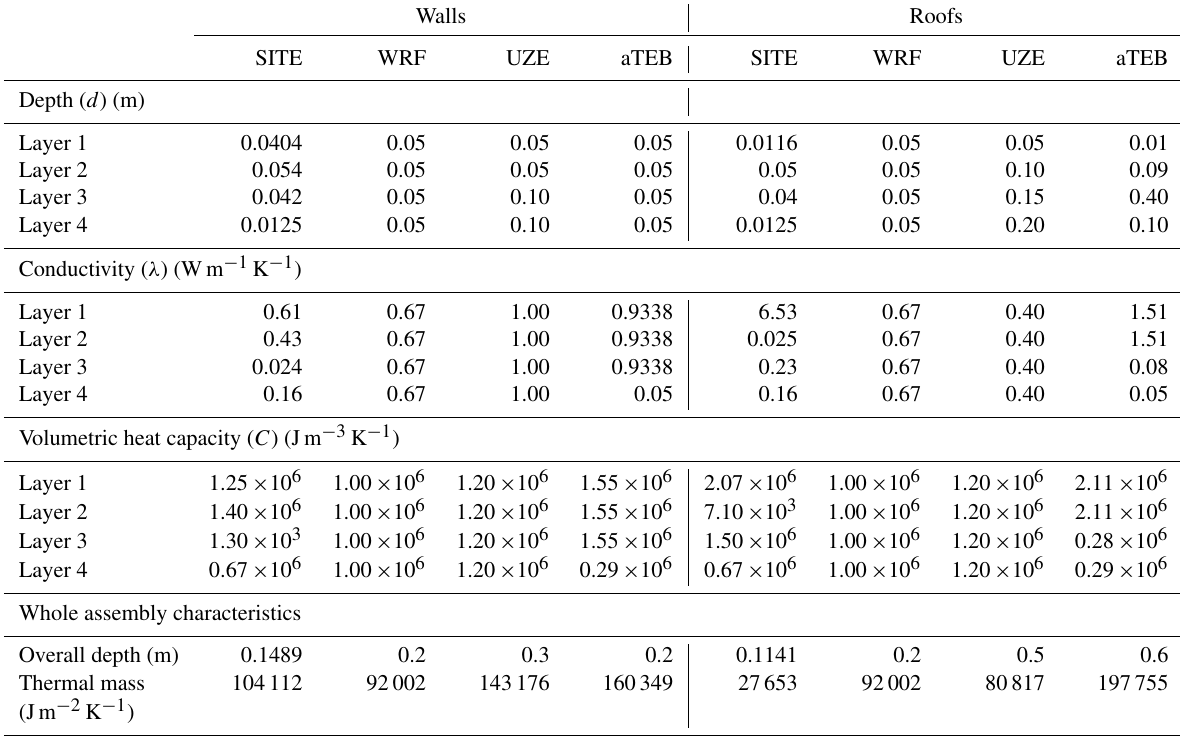
Table A1. Urban land surface model material dataset parameters. References per text in Appendix